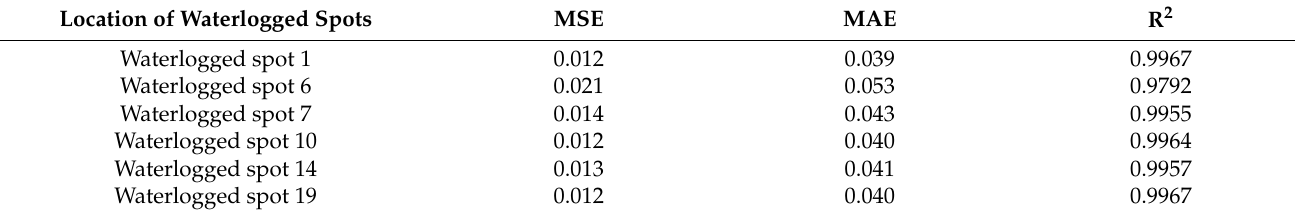
Table 2. Water depth prediction model accuracy